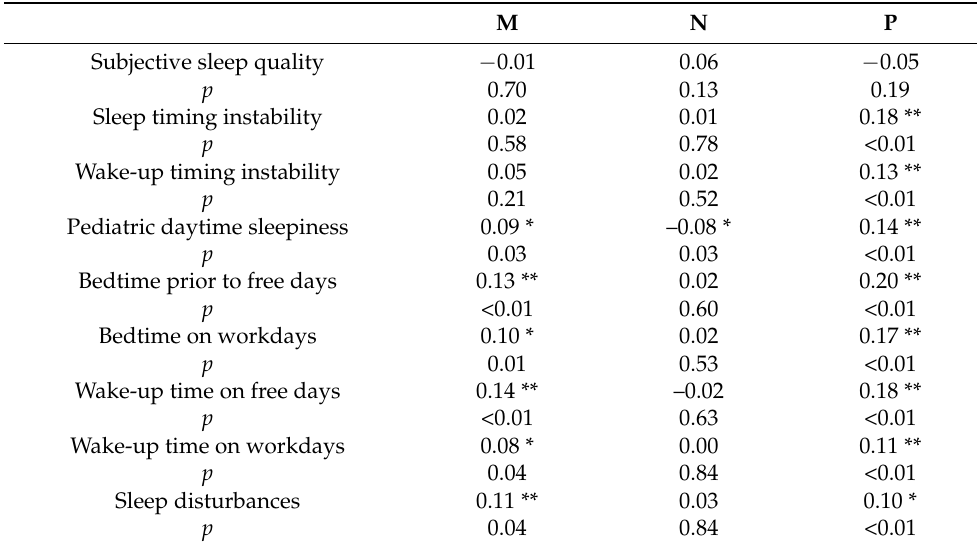
Table 1. The relationship between Dark Triad traits and sleep variables. M N P Subjective sleep